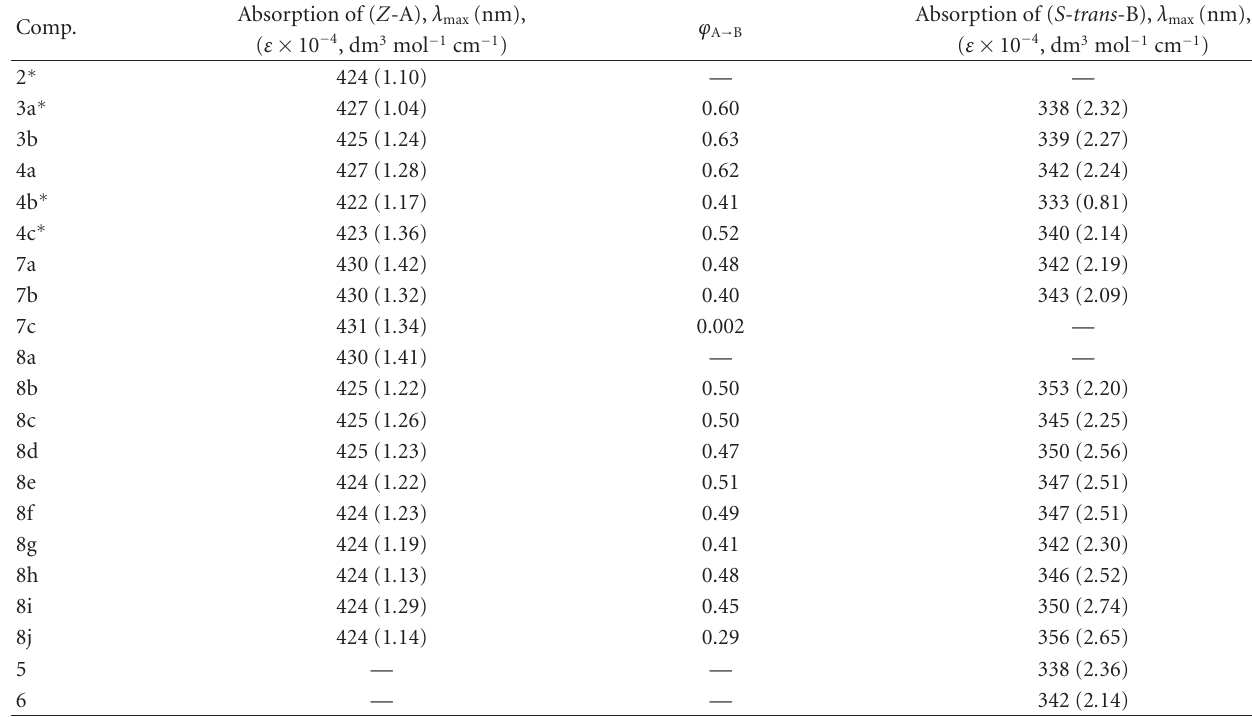
Table 1: Spectral characteristics (long-wave length maxima) of (2)–(8) in acetonitrile solutions and quantum yields ( ϕ ) of the A → B rearrangement. Absorption of ( Z -A), λ max Comp.